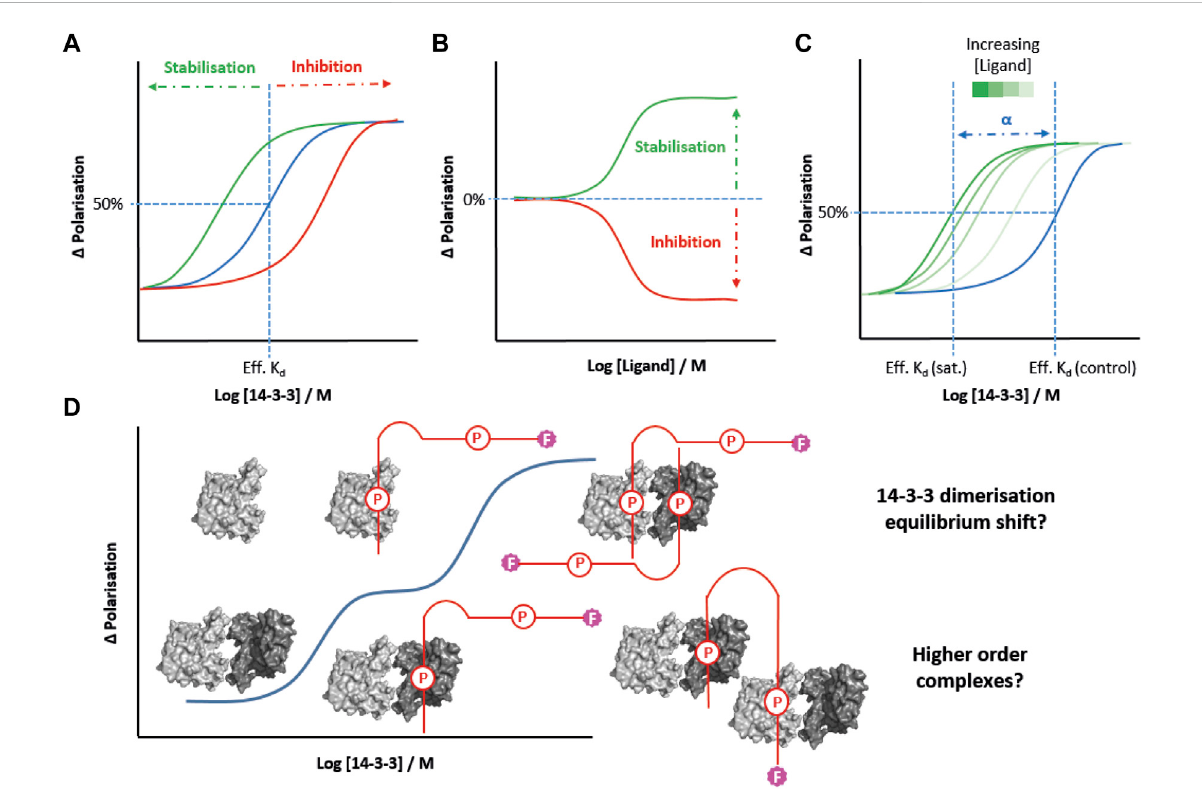
FIGURE 2 FPstrategies for studying 14-3-3 PPIs. (A) 14-3-3 protein titrationsinto fi xedconcentrationsof amolecularglue (green)and aPPI inhibitor(red) allow for comparison of effective K d s (Eff. K d ) compared to a control experiment (blue). (B) Titration of molecular glues or PPI inhibitors into fi xed concentrations of 14-3-3 protein can determine EC 50 values. (C) 2D titration of 14-3-3 protein in the presence of increasing fi xed concentrations